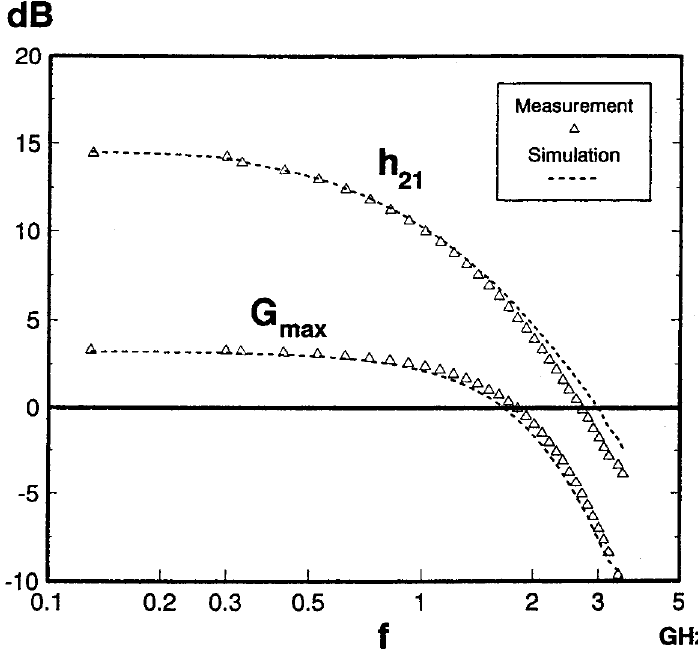
FIGURE 8 Comparison between the measured and calculated f T , f max